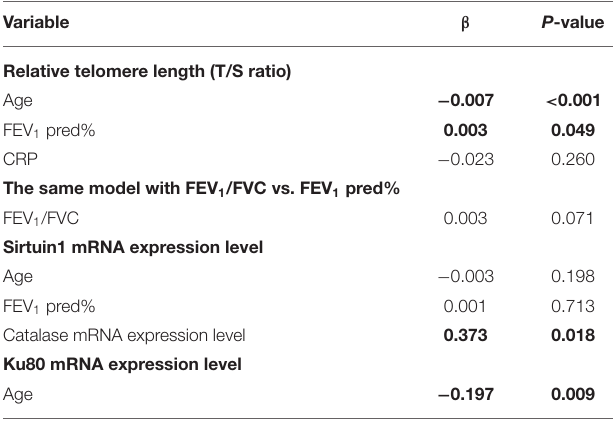
TABLE 2 | The multivariate association between aging marker expression in PBMCs and the clinical variables in bronchiectasis. Variable β P